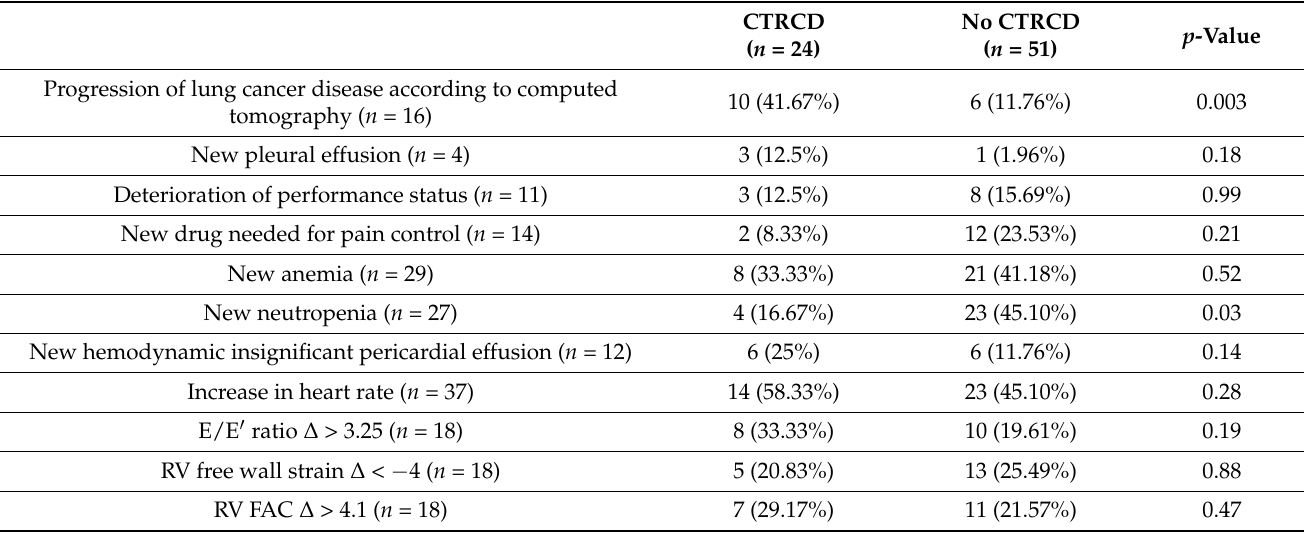
Table 4. Correlation between diagnosis of CTRCD (cancer-therapeutics-related cardiac dysfunction) and different probable signs of lung cancer disease